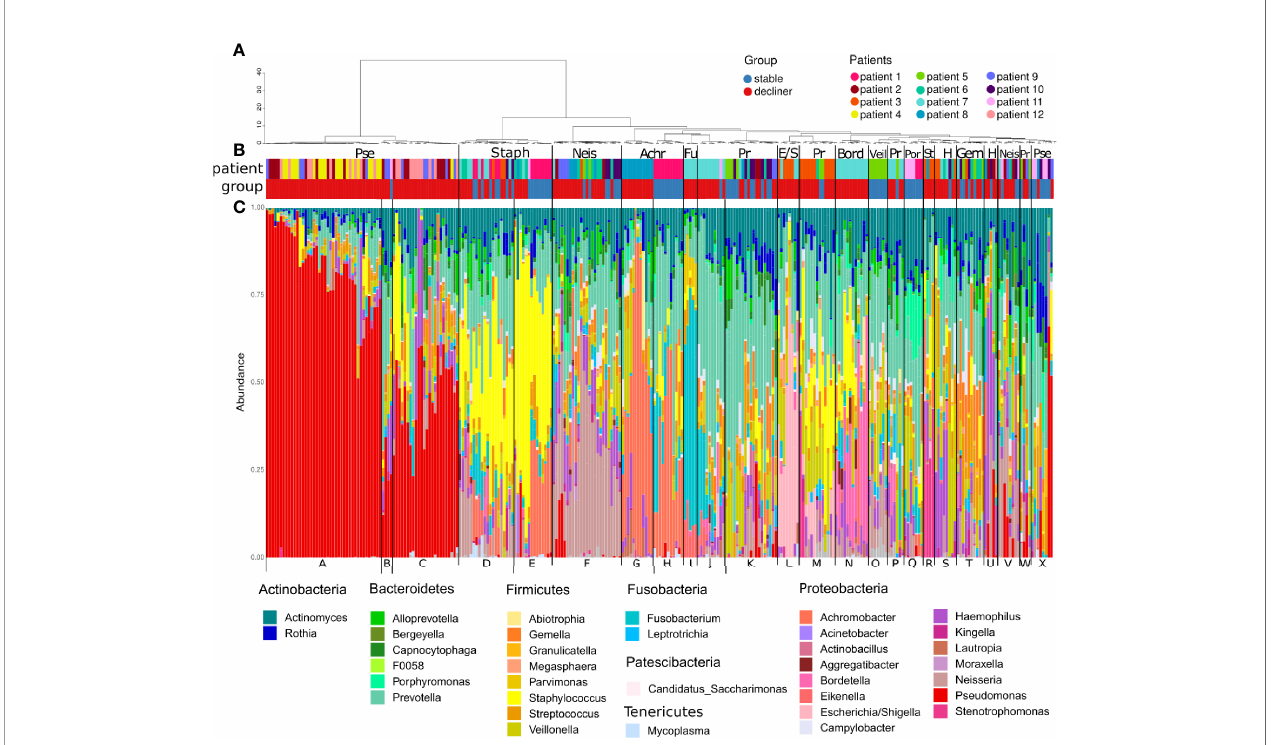
FIGURE 1 | Microbiome composition of each sample grouped by hierarchical clustering. (A) Dendrogram representing the hierarchical clustering of the samples. (B) Colored bars showing the af fi liation of the samples to a patient (pat) and the patient FEV-group (group; stable or decliner). The most abundant genera are written above the colored bars to name the clusters. Pse, Pseudomonas ; Staph, Staphylococcus ; Neis, Neisseria ; Achr, Achromobacter ; Fu, Fusobacteria ; Pr, Prevotella ; E/S, Escherichia/Shigella ; Bord, Bordetella ; Veil, Veillonella ; Por, Porphyromonas ; St, Stenotrophomonas ; H, Haemophilus ; Gem, Gemella. (C) Relative abundance of the genera, which occurs in at least one sample with a relative abundance ≥ 5%. All other genera are cumulated as “ Others. ” The letter at the bottom indicates the cluster